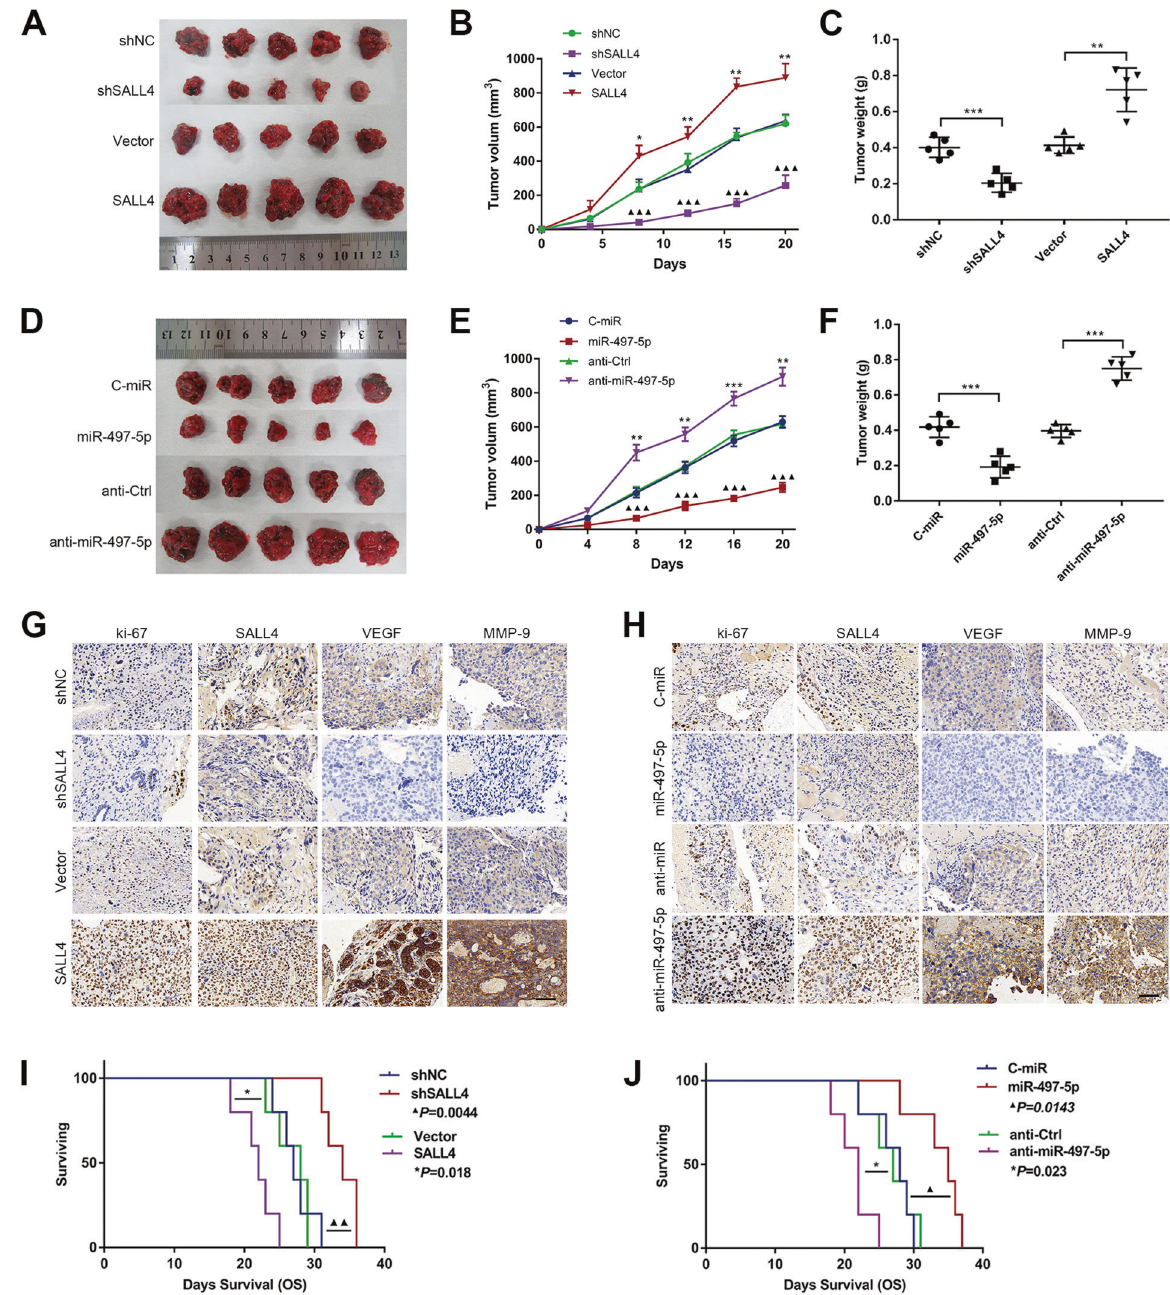
Fig. 4 Effects of miR-497-5p and SALL4 on choriocarcinoma in vivo. A Growth of subcutaneous xenograft tumors for following groups of shNC, shSALL4, vector, or SALL4, with 5 tumors per group. B Tumor volumes were measured every 4 days for 3 weeks (*SALL4 vs. vector; ▲ shSALL4 vs. shNC). C Tumor weight in the indicated mice. D Comparison of tumor sizes among C-miR, miR-497-5p, anti-Ctrl, or anti-miR-497- 5p groups ( n = 5 each group). E Tumor volumes were measured every 4 days for 3 weeks (*anti-miR vs. anti-Ctrl; ▲ miR vs. C-miR). F Tumor weight in the indicated mice. G IHC staining displaying the Ki-67, SALL4, VEGF, and MMP-9 protein expression among shNC, shSALL4, vector, or SALL4 groups (IHC, magni fi cations: ×400). H IHC staining displaying the Ki-67, SALL4, VEGF, and MMP-9 protein expression among C-miR, miR-497-5p, anti-Ctrl, or anti-miR-497-5p groups (IHC, magni fi cations: ×400). I Kaplan-Meier curves of shSALL4 and SALL4 mice, compared with the control. J Kaplan-Meier curves of miR-497-5p and anti-miR-497-5p mice, compared with the control. Data represent mean ± SD from at least three independent experiments. * P < 0.05, ** P < 0.01, *** P < 0.001. promoted DNMT1 and DNMT3b expression in CSLCs (Fig. 7D, P < expression correlation analysis, con fi rming a signi fi cant positive 0.01). On the basis of all the above results, we hypothesized correlation among patient samples (Fig. 7B, P < 0.01). To further whether a feedback loop exists in the progression of CSLCs. First, study if SALL4 could actively recruit DNMT proteins, endogenous in eight choriocarcinoma tissues, as shown in Fig. 7E, miR-497-5p Co-IP followed by western blotting analysis was used to transcript level was remarkably negatively correlated with DNMT1 demonstrate that SALL4 successfully interacted with DNMT1 and (Spearman r = − 0.7545, P = 0.0377) but not with DNMT3b DNMT3b (Fig. 7C). Moreover, SALL4 overexpression signi fi cantly